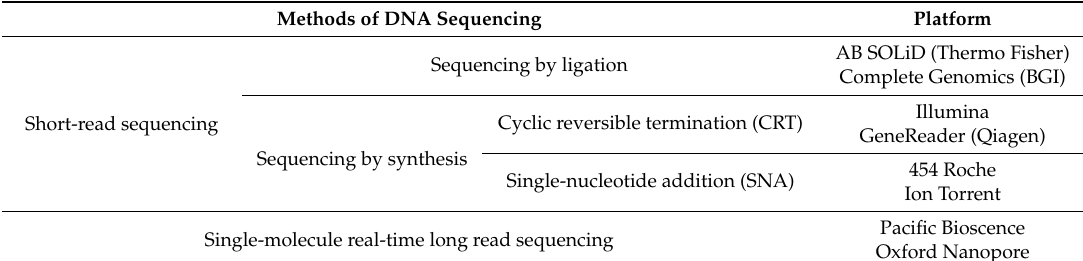
Table 1. Massive sequencing platforms presently available.